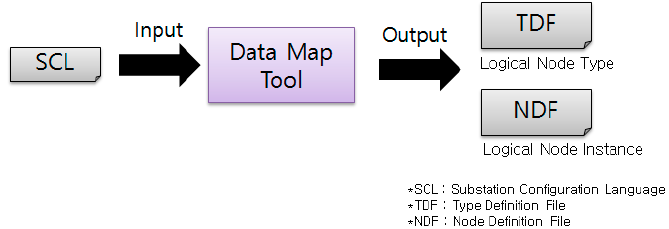
Figure 9. Step 1: Creation of TDF (type definition file) and NDF (node definition file).